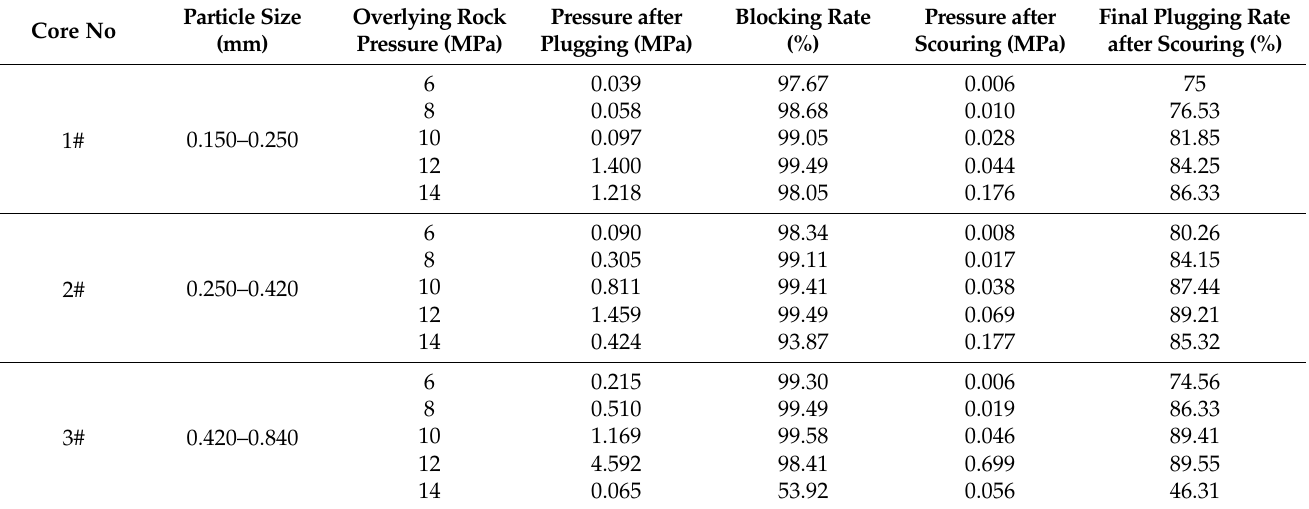
Table 13. Final plugging rates of water-swellable particles of different sizes under different overlying rock